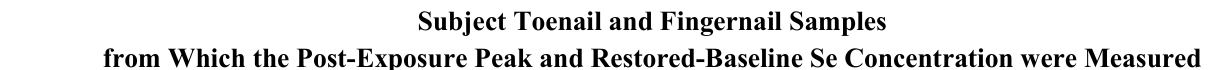
Table 3. Summary of toenail and fingernail Se concentrations among subjects with post-exposure peak and restored-baseline measurements 1